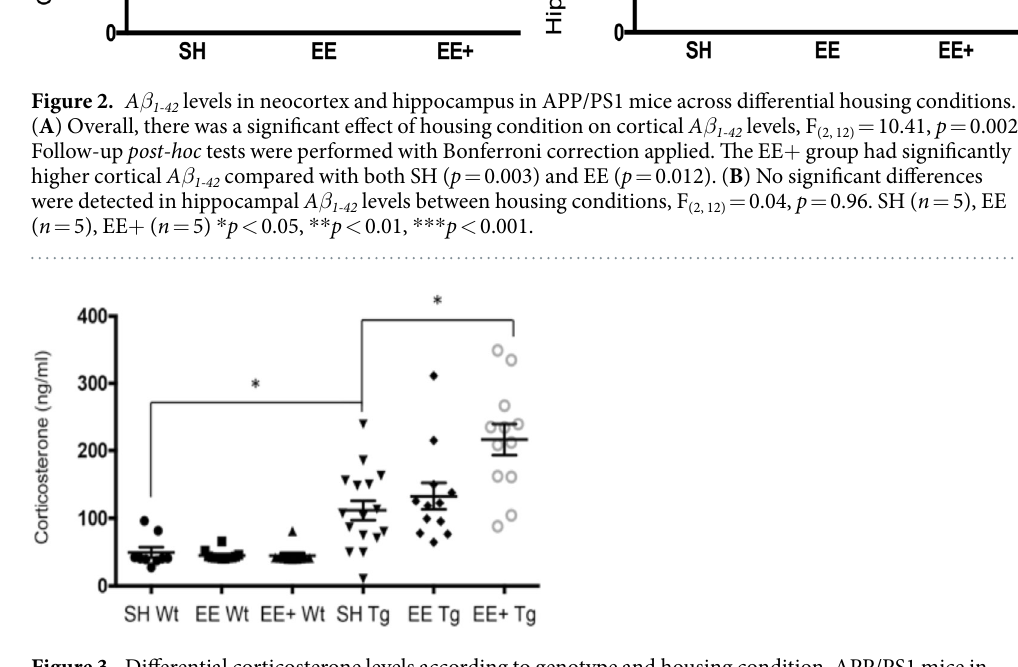
Figure 3. Differential corticosterone levels according to genotype and housing condition. APP/PS1 mice in SH had significantly higher levels of corticosterone in blood serum compared to healthy Wt control mice at 12 months, t (24) = 2.34, p = 0.03. There was a significant interaction effect of genotype × housing on levels of corticosterone, F (2, 66) = 3.76, p = 0.03. In Wt mice, there was no significant effect of housing on corticosterone, F (2, 28) = 0.31, p = 0.74. Housing condition produced a significant effect on corticosterone levels in APP/PS1 mice, F (2, 38) = 4.8, p = 0.01. Bonferroni adjusted post hoc tests revealed EE + mice had significantly higher corticosterone levels compared to SH ( p = 0.02). Moreover, EE + mice had higher corticosterone levels than mice housed in EE ( p = 0.049), however, this was no longer significant when Bonferroni correction was applied ( p = 0.057). SH Wt ( n = 9), EE Wt ( n = 12), EE + Wt ( n = 10); SH Tg ( n = 17), EE Tg ( n = 12), EE + Tg ( n = 12) * p < 0.05, ** p < 0.01, *** p <